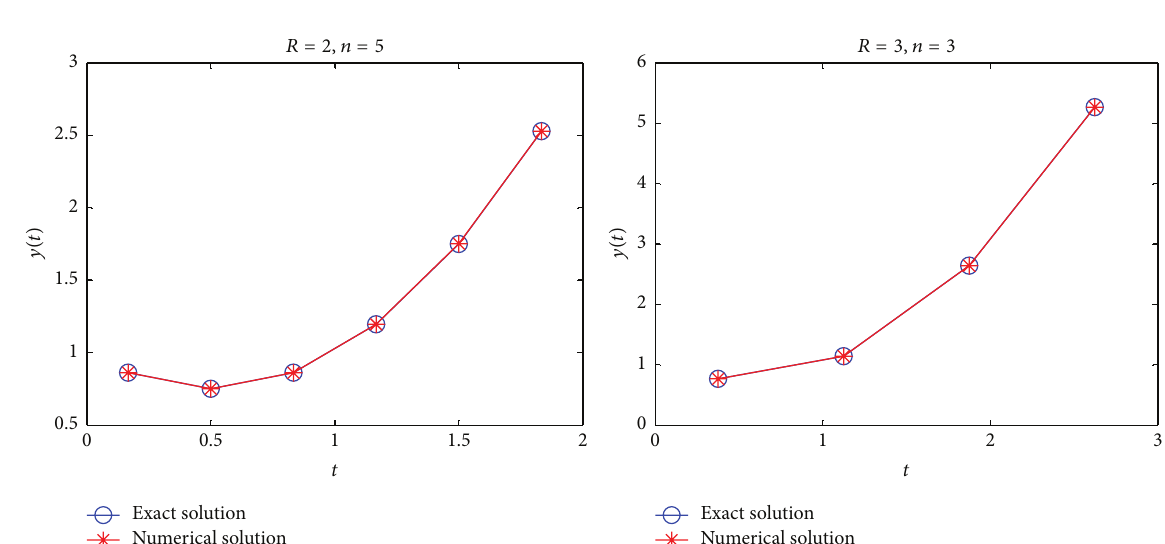
Figure 2: Exact solution and numerical solution of Example